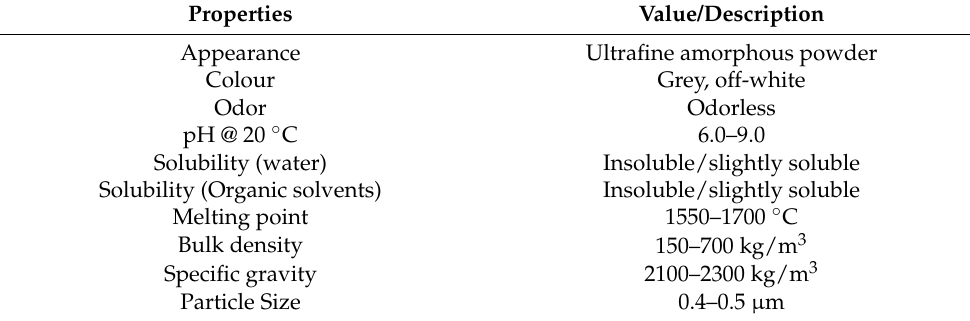
Table 2. Physical and chemical characteristics of SF.